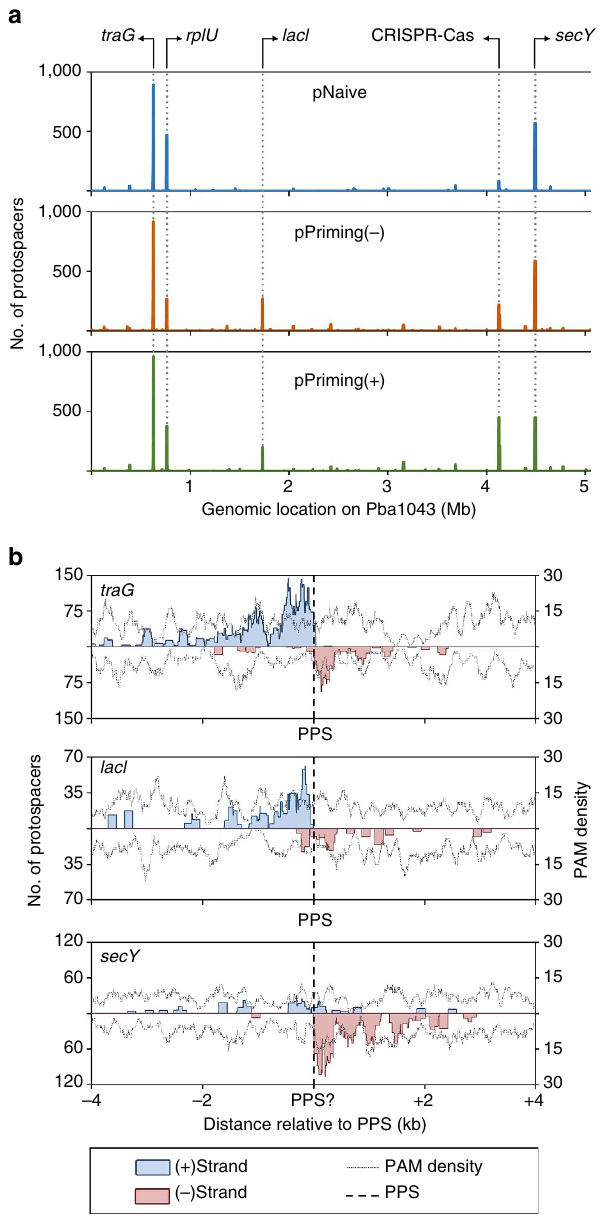
Figure 8 | Mapping of chromosomal protospacers. ( a ) Mapping of the chromosomal targeting spacers obtained in the pNaive (upper, blue), pPriming( (cid:2) ) (middle, orange) and pPriming( þ ) (bottom, green) experiments using a 3,000nt window sliding in 10nt increments. Genes at the centre of protospacer ‘hot spots’ are indicated on top of the panel. ( b ) Protospacer locations of three chromosomal ‘hot spots’ using a sliding 150nt binning window: traG (top), lacI (middle) and secY (bottom). ‘PPS?’ indicates the possible location of an unidentified priming event. Labelling is the same as Fig.